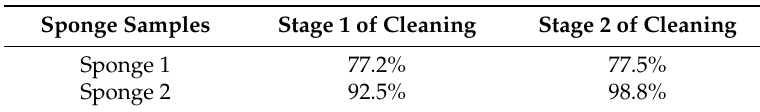
Table 3. Percentage of cleaning for two sponges, sponge 1 (magnetite powder dispersed olive oil) and sponge 2 (brominated vegetable oil mixed olive oil).